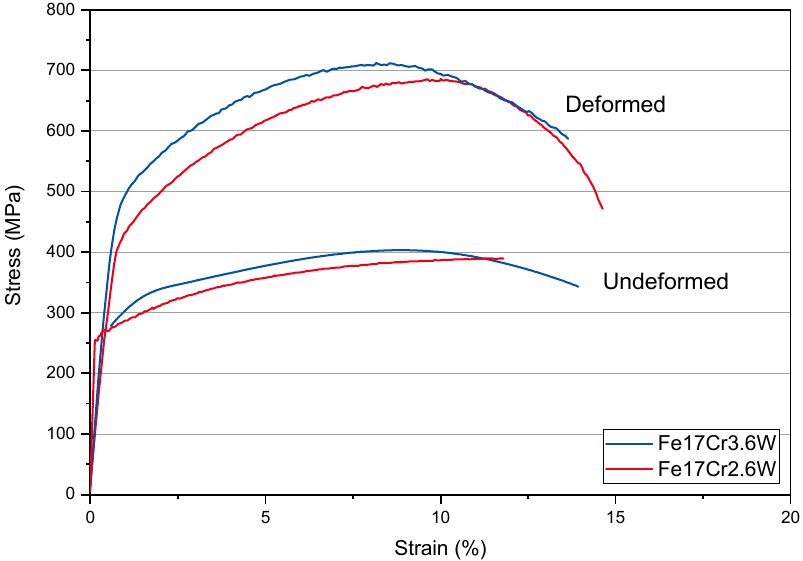
Figure 9. Tensile test results of model alloys Fe17Cr2.6W and Fe17Cr3.6W after the newly developed thermomechanical processing chain in comparison to an undeformed, precipitate ‐ free state.